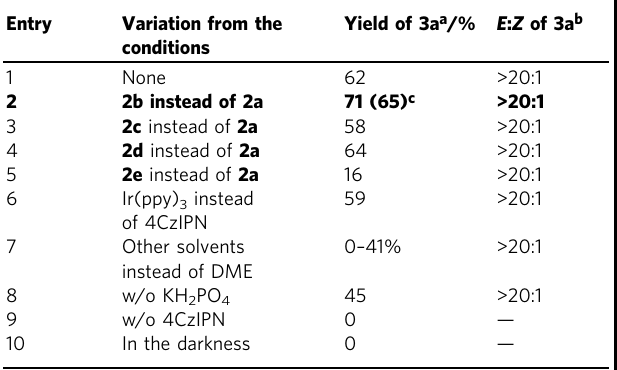
Table 1 Optimization of the reaction